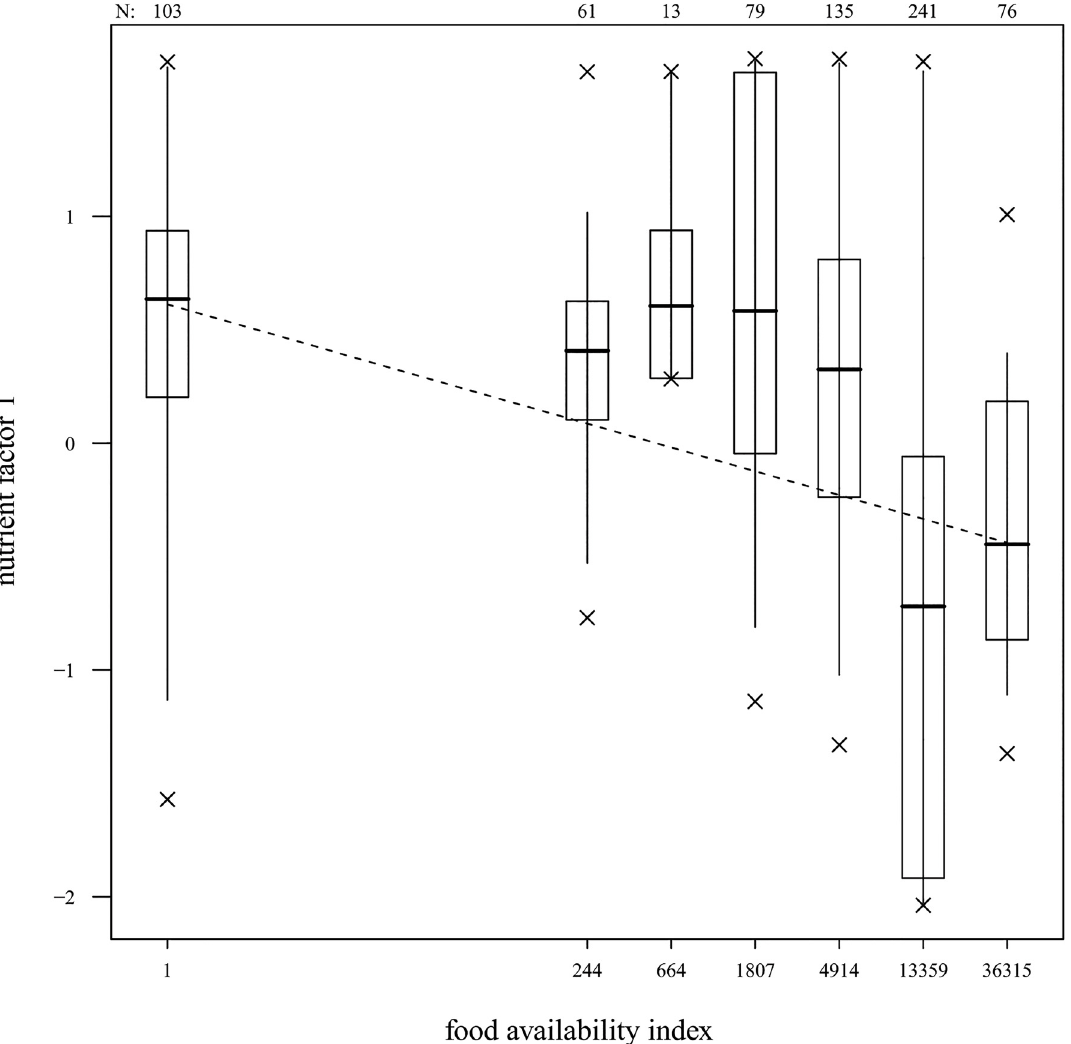
Fig 3. Nutrient intake (Factor 1 of PCA; see Tables 3 – 4a) at times of different food availability. The line shows the relation between the nutrient intake variables included in factor 1 and food availability as estimated with a GLMM (the model corresponds to that depicted in Table 5). Bold vertical lines indicate medians; boxes show the first and third quartiles, vertical lines the percentiles 2.5 and 97.5% and laying crosses denote the minimum and maximum. Numbers on the top of the graph denote the sample